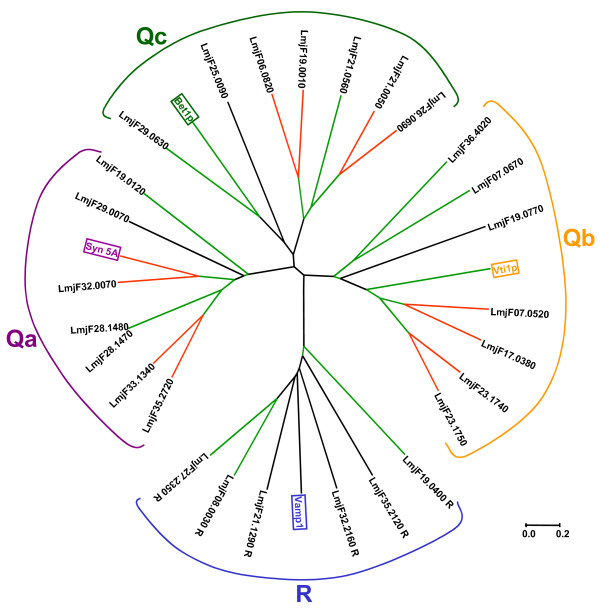
Unrooted tree of L. major SNARE domain-containing proteins. A 71 amino acids-long SNARE motif (see Figure S1 from Additional file 1) from L. major predicted SNARE proteins was aligned using the Clustal W algorithm and a phylogenetic tree was generated as described in the Methods section. Selected characterised members from the Qa, Qb, Qc and R groups were included in the analysis (boxed). They are, respectively, human Syntaxin 5A (NP_012262), yeast Vti1p (Q04338), yeast Bet1 (NP_012262) and human Vamp1 (CAA88760). Branches with bootstrap values > 45 in green and > 90 in red. The scale bar represents 0.2 mutational changes per residue (20 PAM units). L. major sequences are labelled with their identifier in the GeneDB database [39].